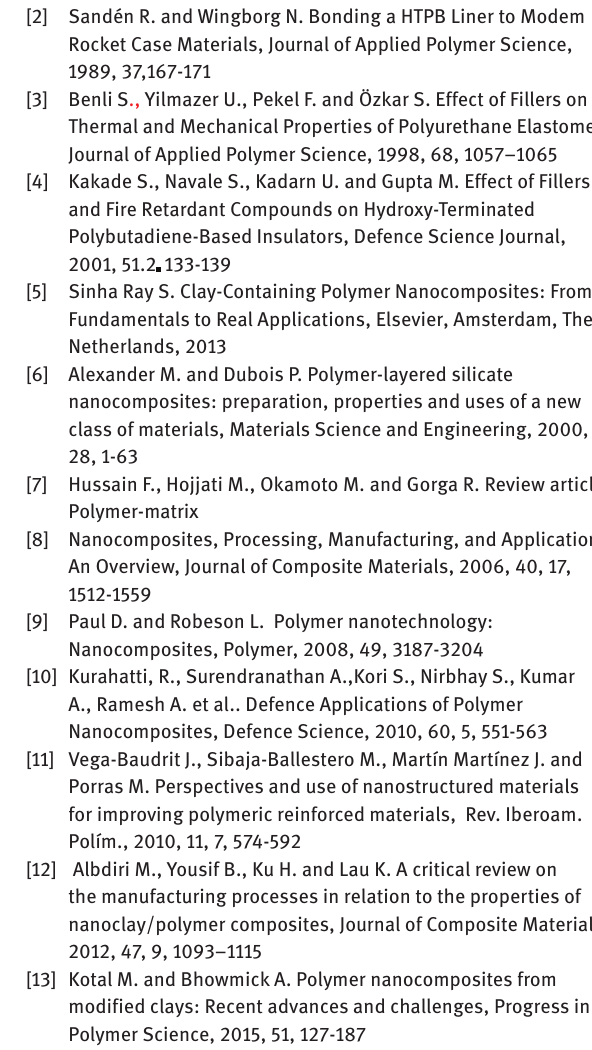
Figure 6: Atomic Force Microscopy of polyurethane liner without C20A nanoclay (left) and NPU with C20A nanoclay (right). Scale: 3 μm .